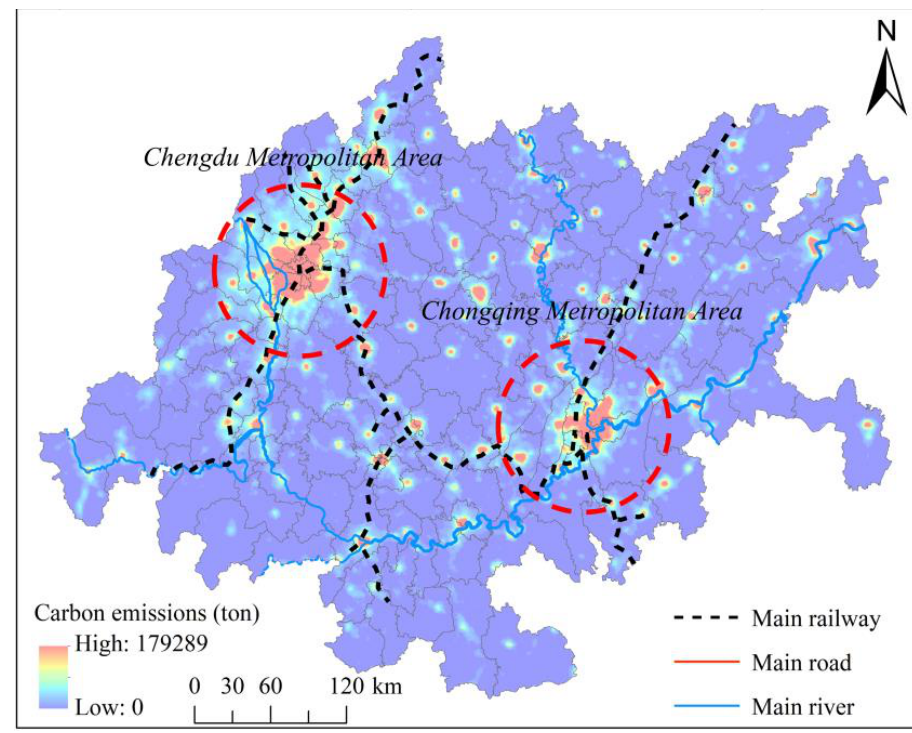
Figure 5 . Geographical spatial distribution of average carbon emissions from 2000 to 2018. 302 Figure 5. Geographical spatial distribution of average carbon emissions from 2000 to